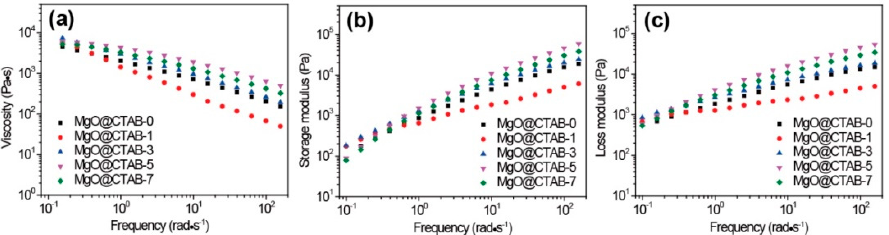
Figure 7. Dynamic rheological properties of PBAT nanocomposites with various contents of MgO@CTAB. ( a ) Complex viscosity, ( b ) storage modulus, and ( c ) loss modulus as a function of frequency.